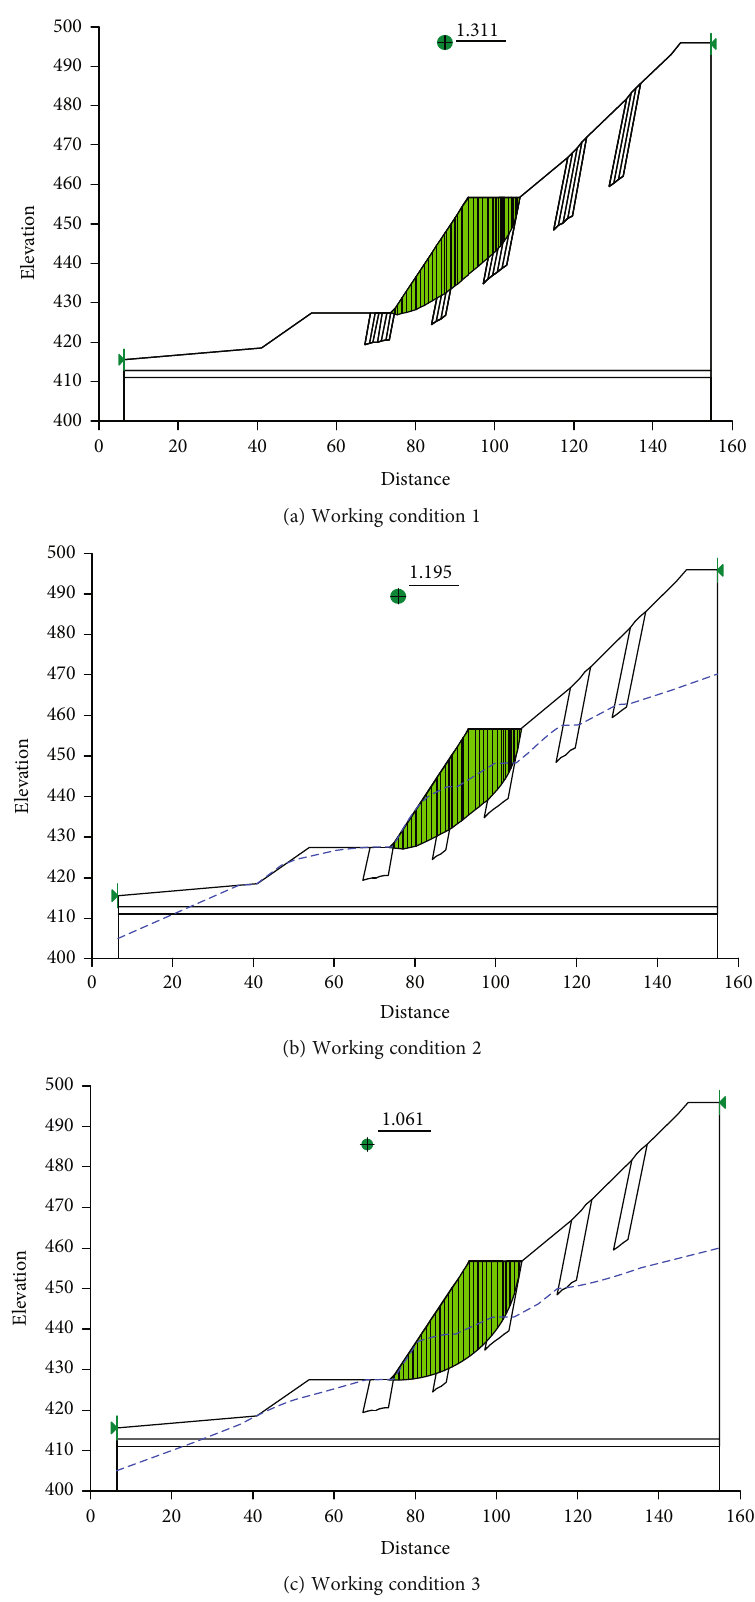
Figure 9: Seepage calculation diagram of section